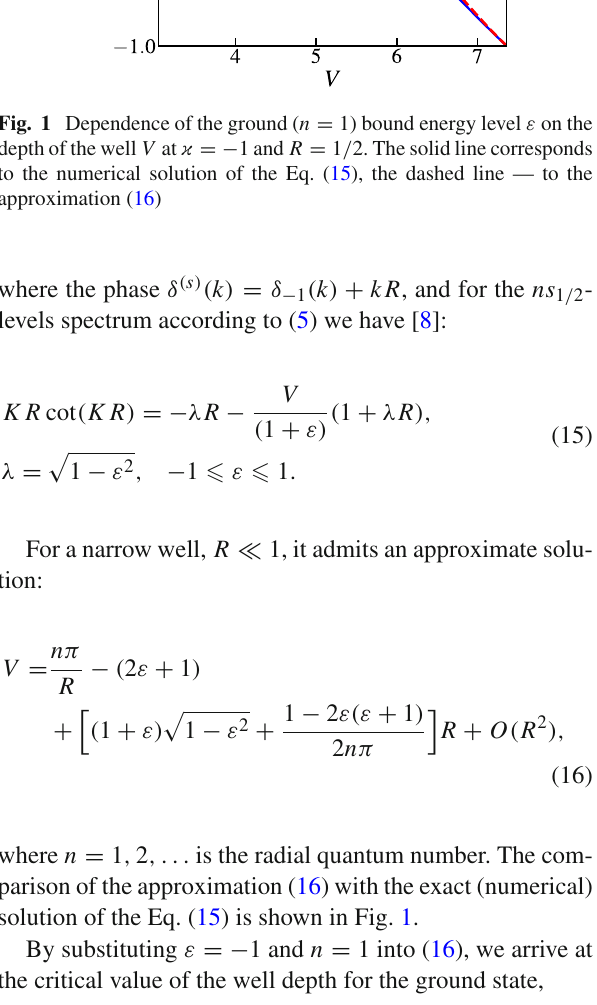
Analytic continuation to the domain V > V